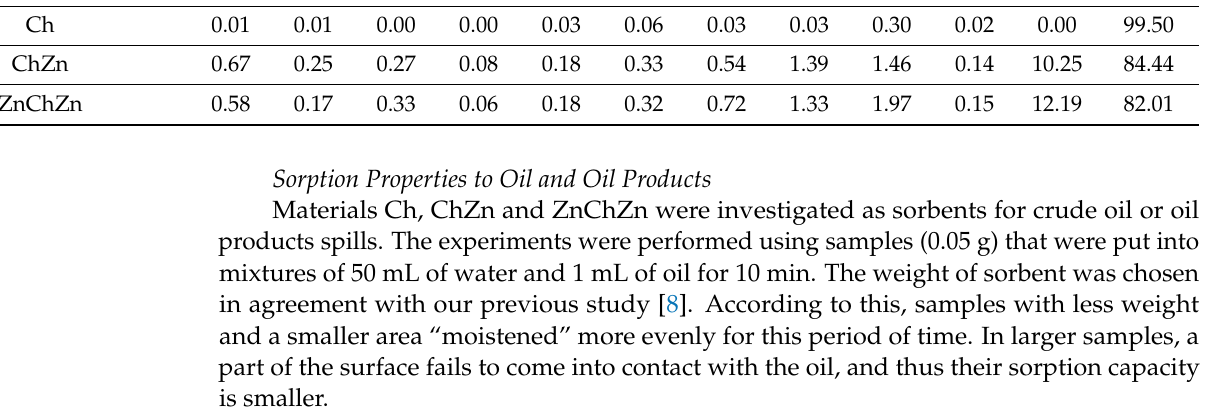
Figure 6. Photoluminescence spectra ( λ exc = 330 nm) of Ch, ChZn, and ZnChZn. The sample compositions obtained from X-ray fluorescence (XRF) analyses are re- ported in Table 2. The column labeled as “matrix” shows the amount of the main com- ponents that make up the materials. These are carbon (C), nitrogen (N), hydrogen (H) and oxygen (O). The results showed that sample Ch does not contain zinc (Zn). The other presented components are in small quantities. The sample ChZn contains 10.25 mass% Zn, while the sample ZnChZn contains 12.19 mass%. This result confirmed that the impregna- tion of cotton fabric with Zn ion solution leads to a small increase in the Zn component in composite material ZnChZn. Table 2. Surface composition of samples Ch, ChZn, and ZnChZn with XRF analysis. Component